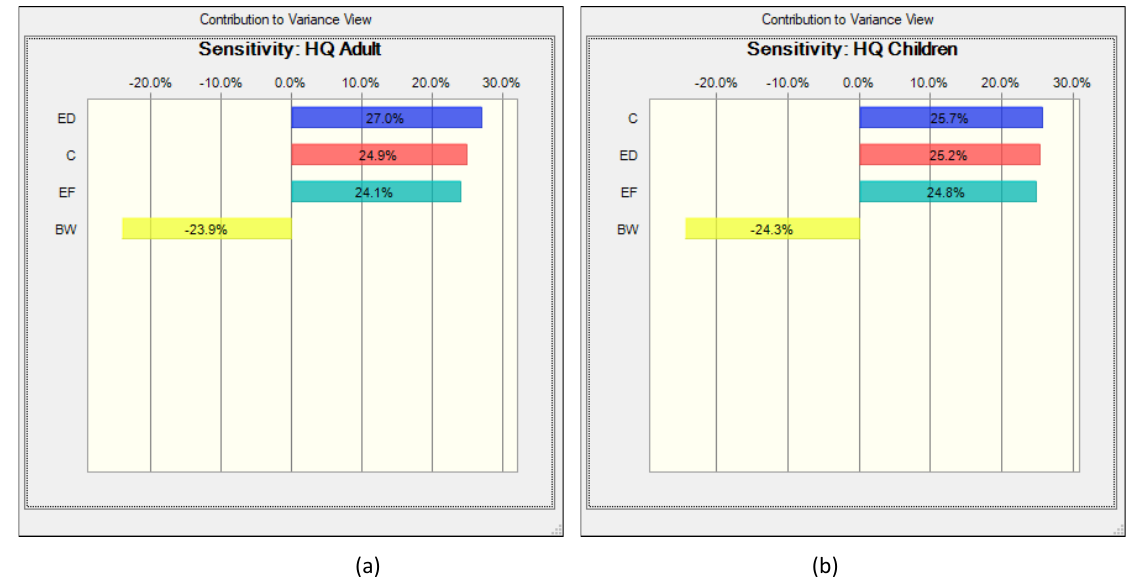
Fig. 5: The sensitivity analysis of the main variables in health risk assessment using Monte Carlo Simulation (MCS)